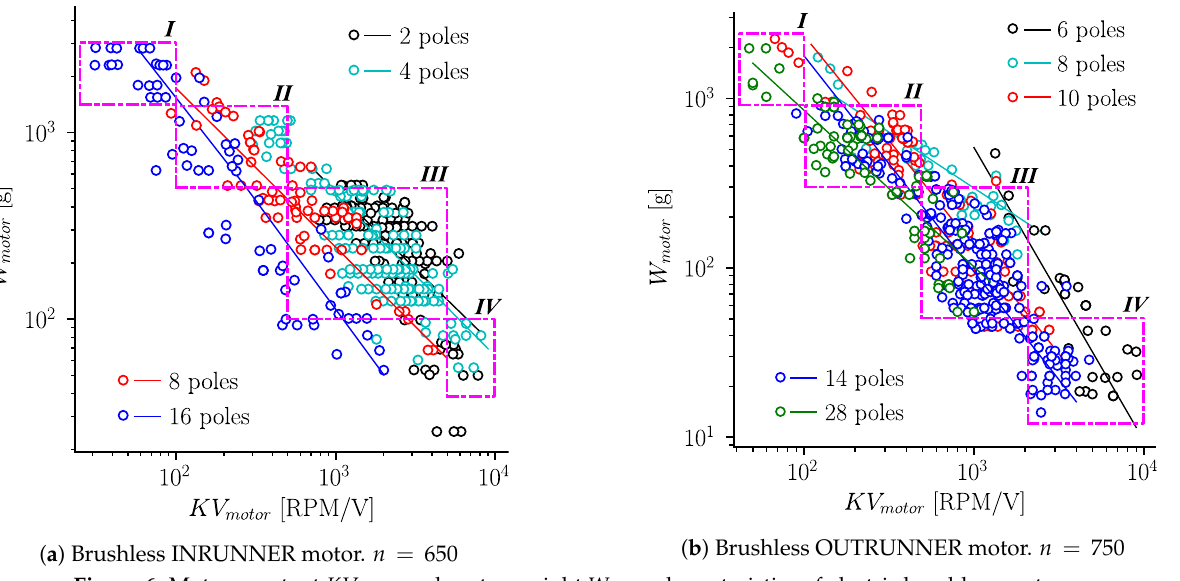
Figure 6. Motor constant KV motor and motor weight W motor characteristics of electric brushless